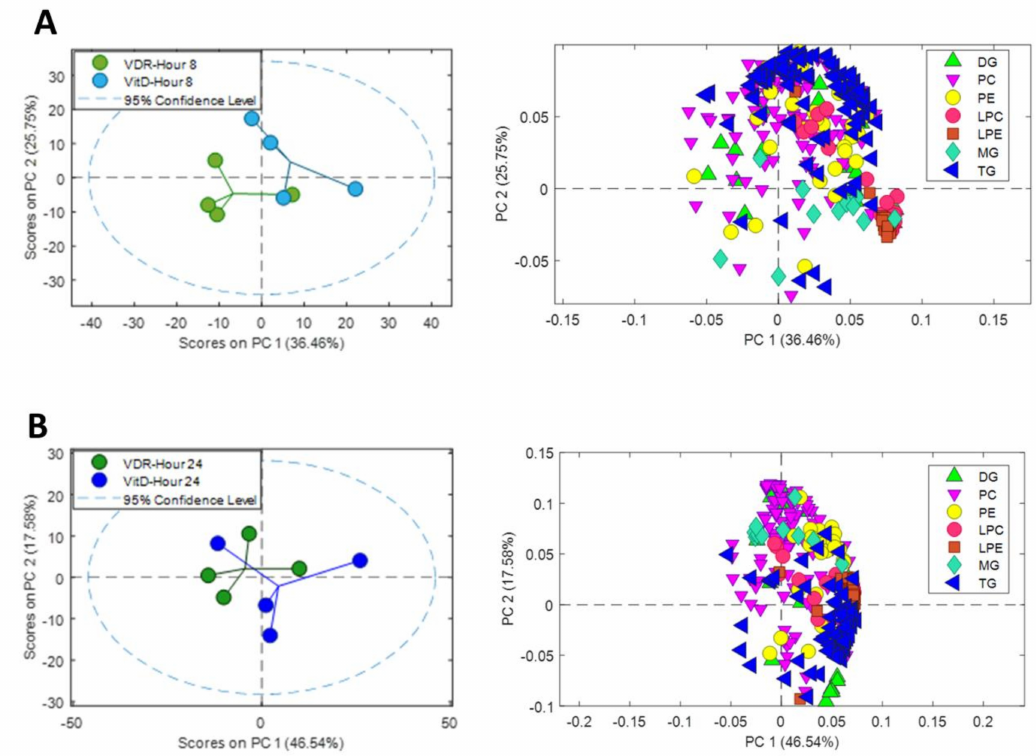
Figure 5. Metabolomic PCA scores plots of human upcyte hepatocytes with VitD-activated VDR. Left: Scores of VDR and VDR + VitD (VitD) hepatocytes after 8 ( A ) and 24 ( B ) h incubation. Right: Loadings for identified triglycerides (TG), diacylglycerols (DG), monoacylglycerols (MG), phosphatidylcholines (PC), phosphatidylethanlolamines (PE), lysophosphatidylcholines (LPC) and lysophosphatidylethanlolamines (LPE) after 8h ( A ) and 24h ( B